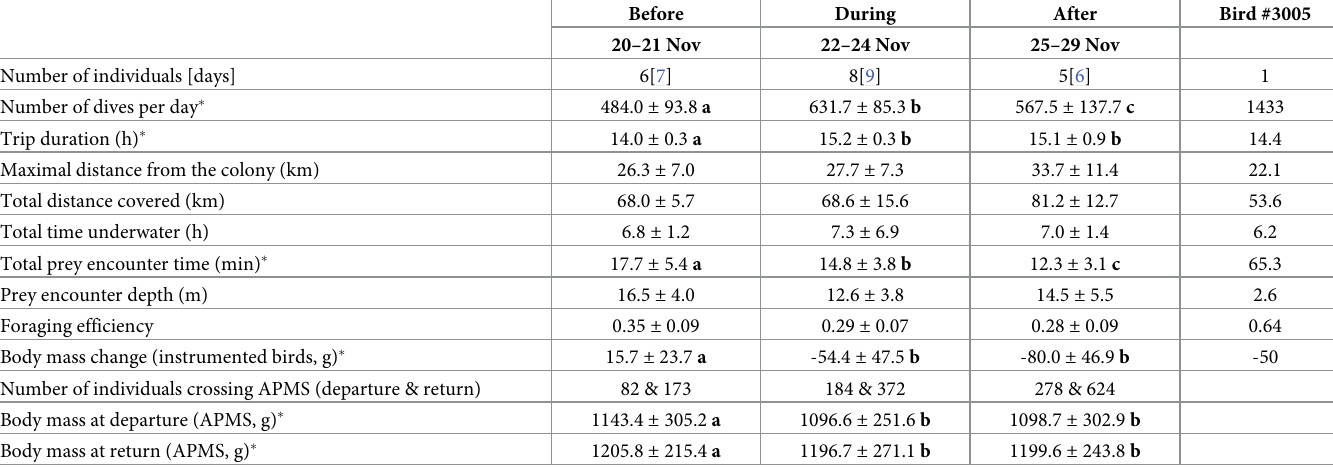
Table 1. Comparison of diving parameters of little penguins from Phillip Island, Australia, foraging at guard phase of breeding, before, during and after a storm event in 2018 (see text).